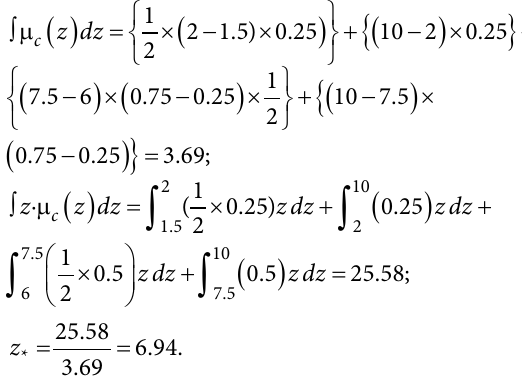
= Based on influence factors for fuzzy inference, 125 rules are created (Table 2). For example, if the possibility of EOT and overlapping are very high (VH), and work